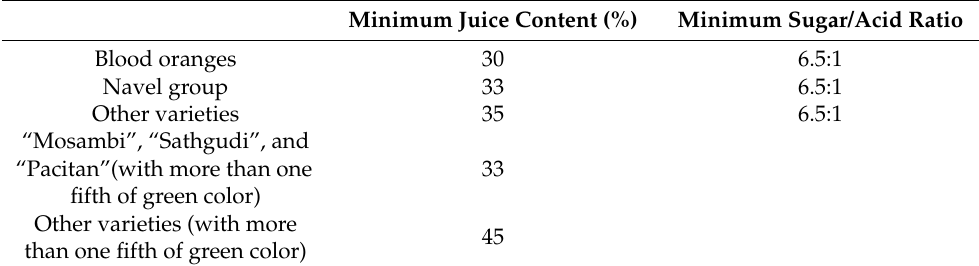
Table 1. Main maturity indices required in EU countries for sweet orange fresh fruits. Minimum Juice Content (%) Minimum Sugar/Acid Ratio Blood oranges 30 6.5:1 Navel group 33 6.5:1 Other varieties 35 6.5:1 “Mosambi”, “Sathgudi”,